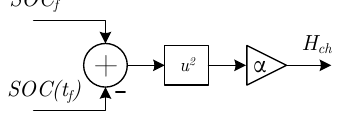
Figure 2. Schematic diagram of the H ch